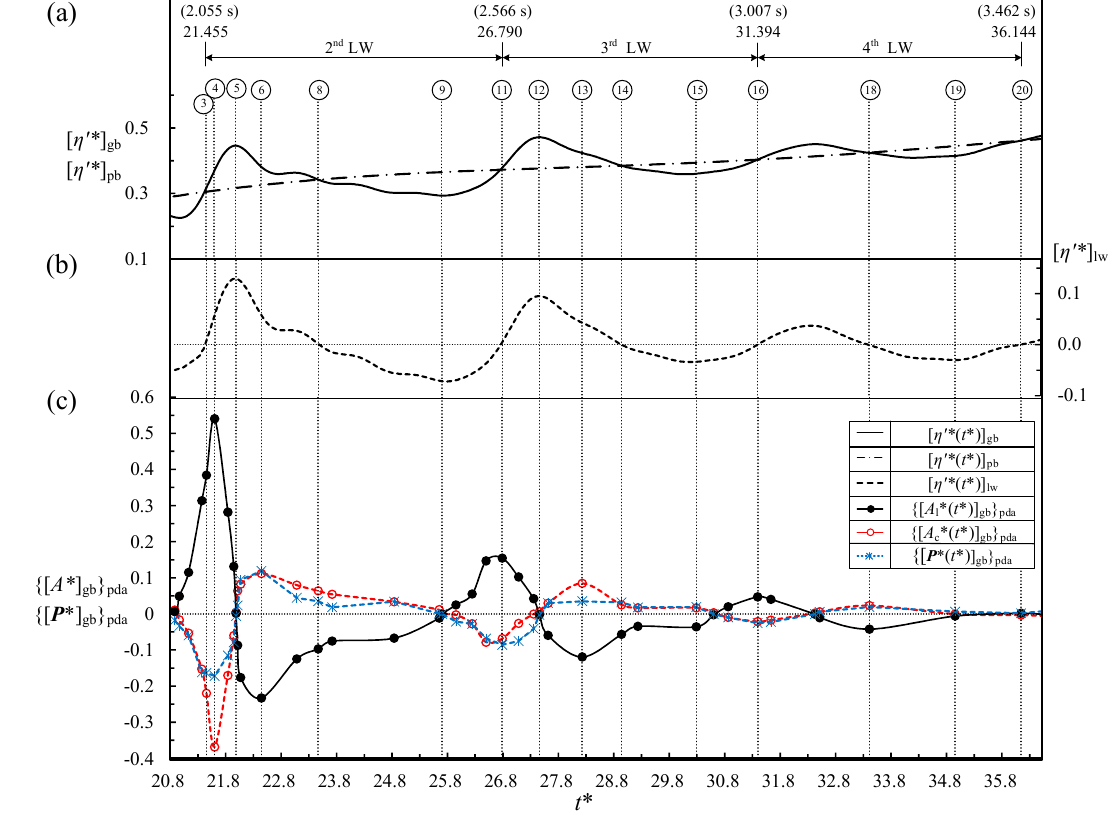
Figure 19. Variations of ( a ) [ η ′ *( t *)] gb and [ η ′ *( t *)] pb ; ( b ) [ η ′ *( t *)] lw ; ( c ) {[ A l *( t *)] gb } pda , {[ A c *( t *)] gb } pda , and {[ P *( t *)] gb } pda in onshore direction with t * for 20.8 ≤ t * ≤ 36.5 at SMS. Times corresponding from circled 3 to 20 are shown in sub-table of Figure 7a,b.